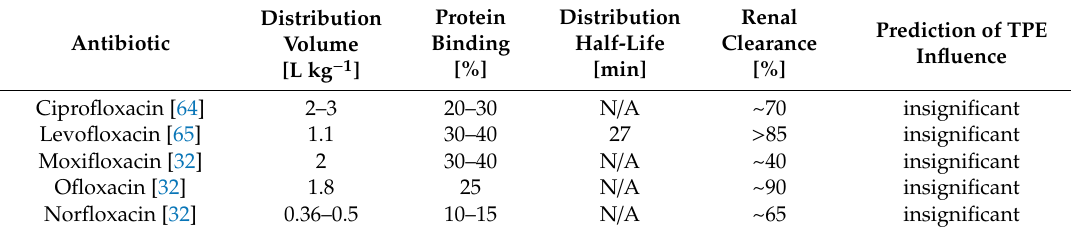
Table 4. TPE and fluoroquinolones.